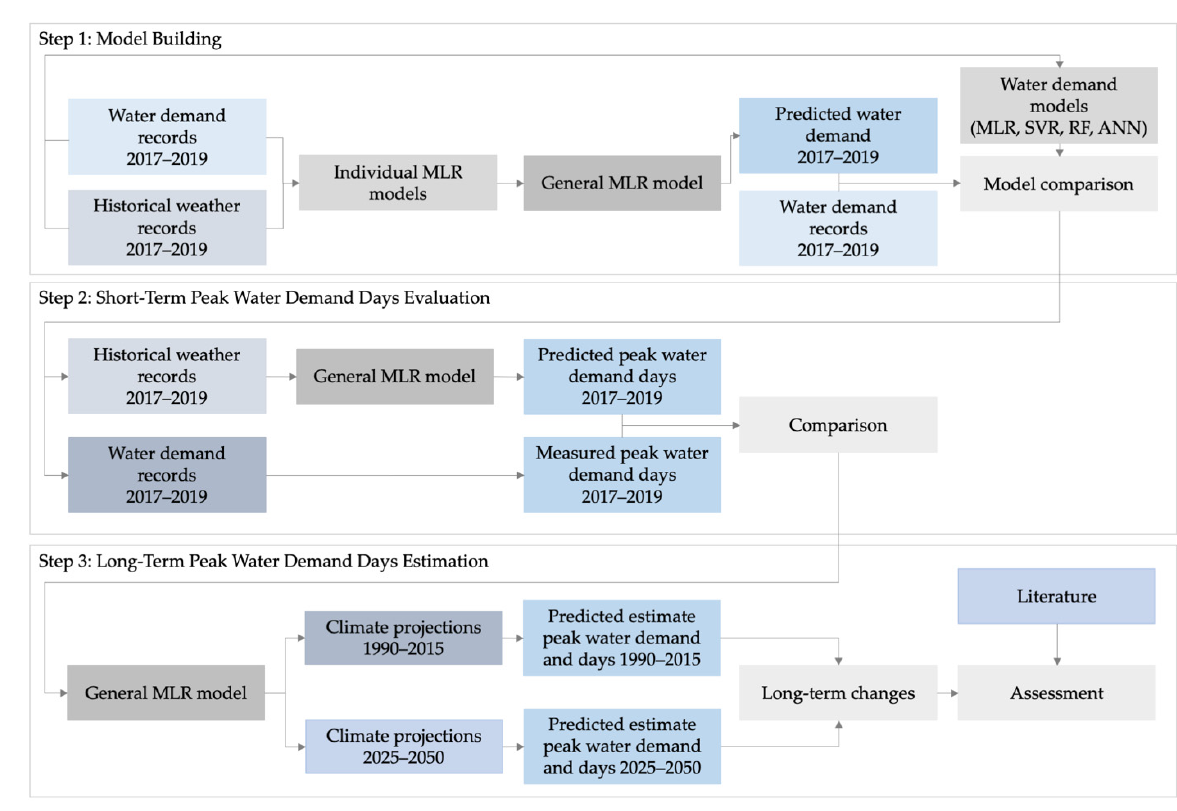
Figure 2. Model building workflow. The model building process is split up into three steps. First model building, second short-term peak water demand days evaluation and last long-term peak water demand days estimation.